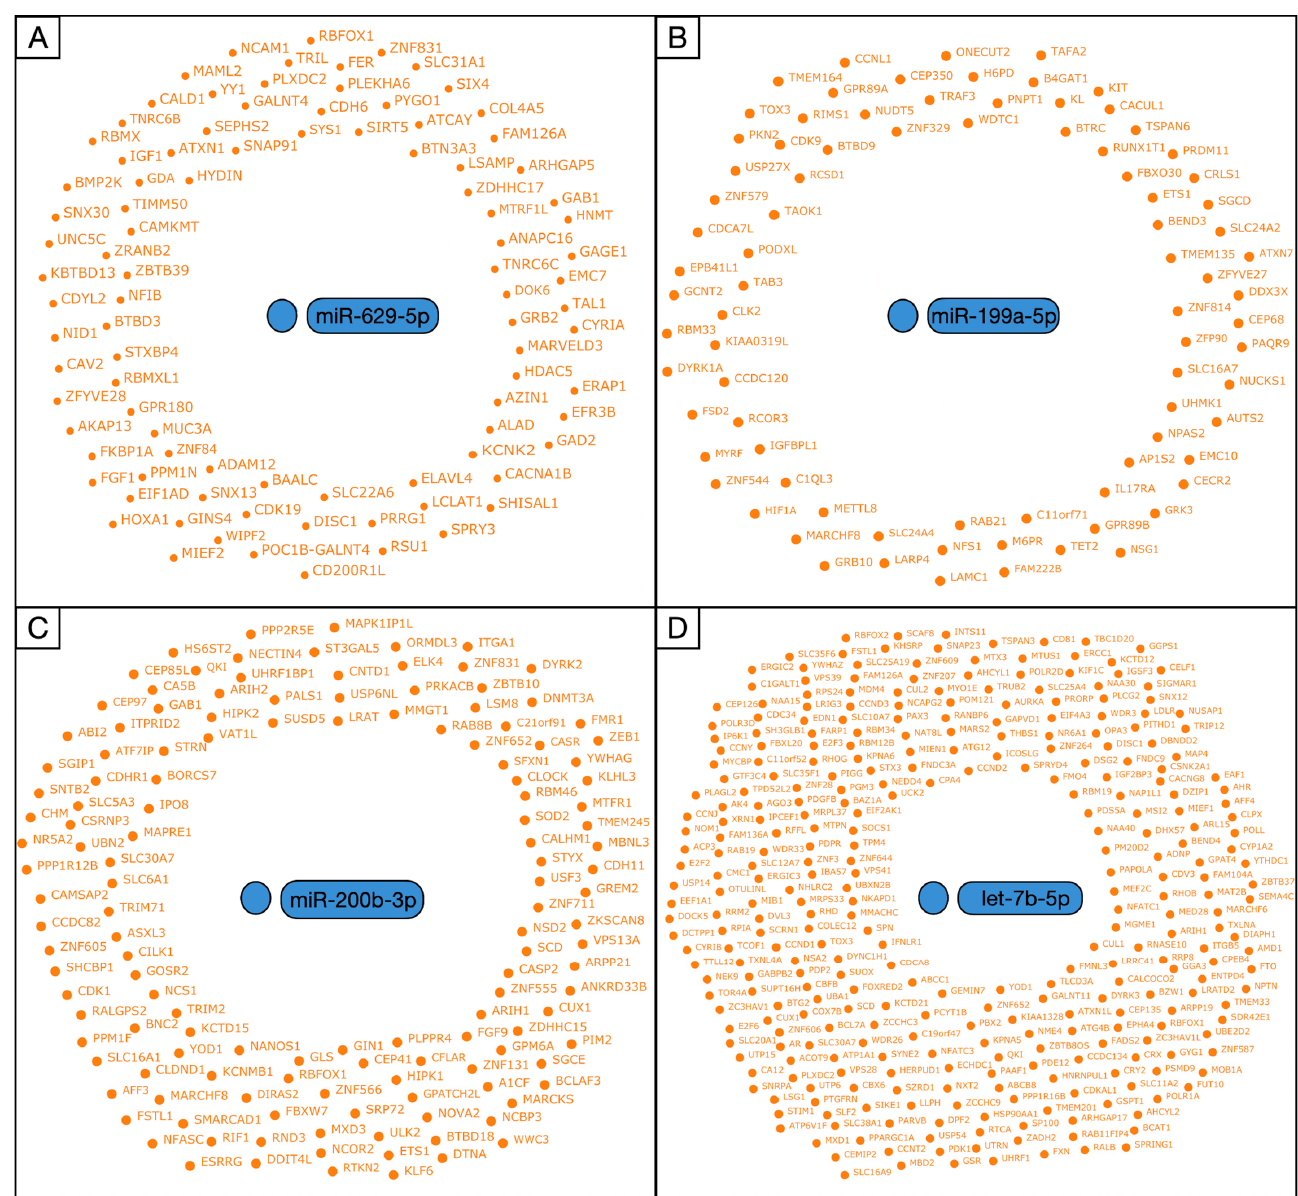
Figure 6. Graphical representation of targets and regulatory networks for the miR-629-5p ( A ), miR- 199a-5p ( B ), miR-200b-3p ( C ), and let-7b-5p ( D ). 199a-5p ( B ), miR-200b-3p ( C ), and let-7b-5p ( D